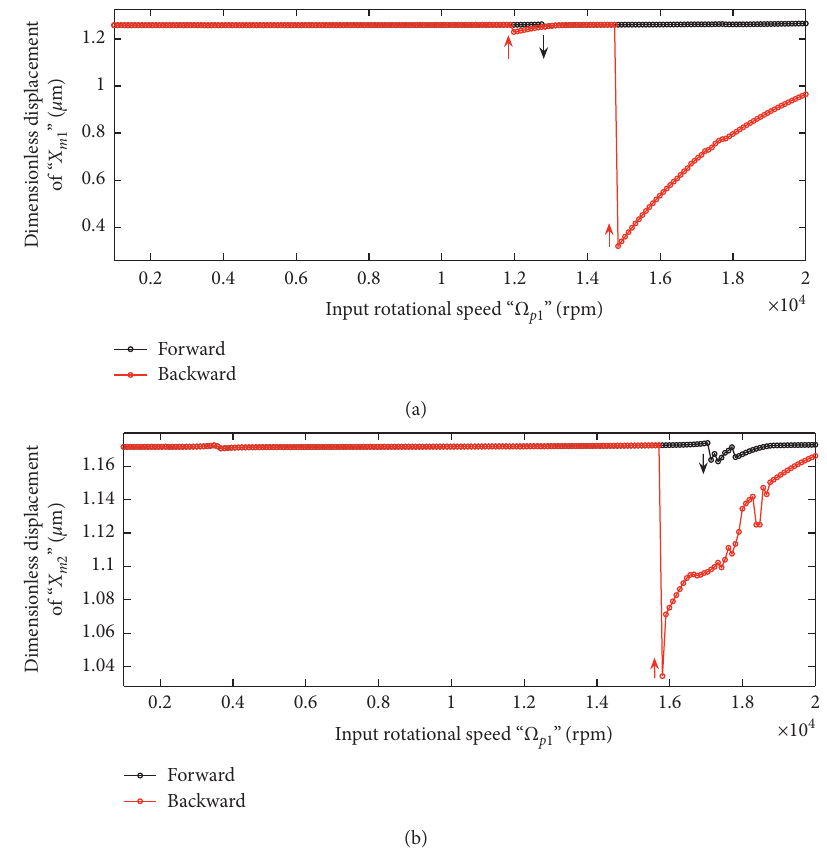
Figure 21: RMS curves of forward and backward bifurcation system; s